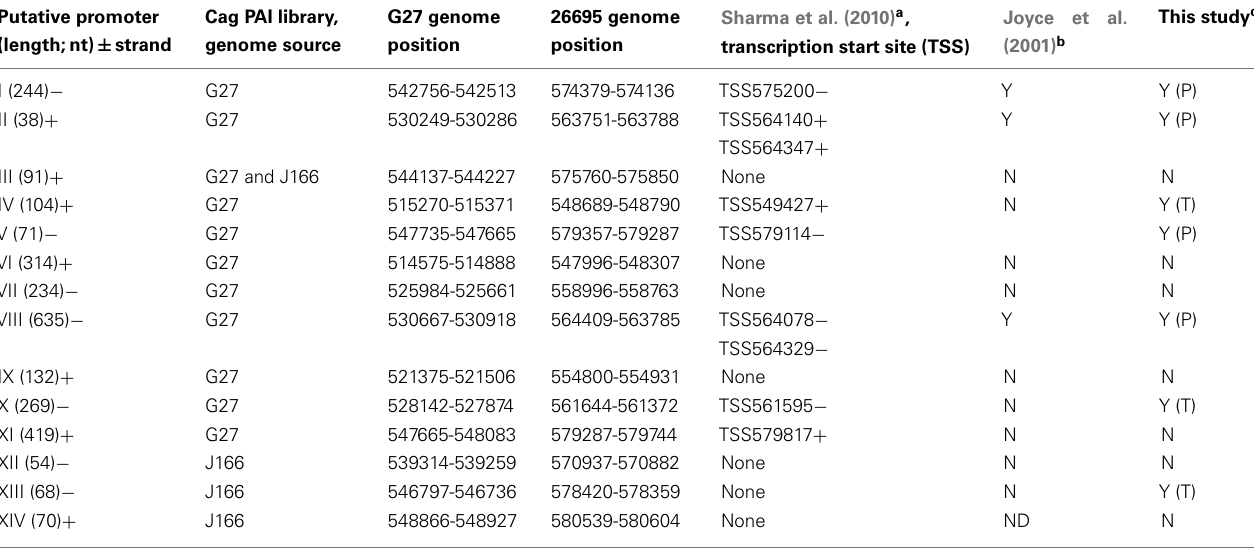
Table 1 | Chromosomal location of putative cag PAI promoters.